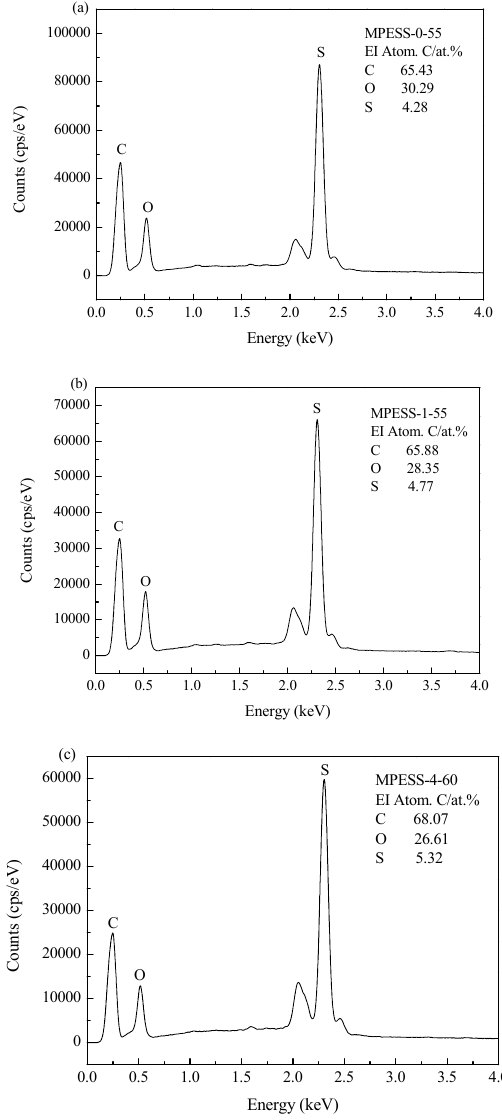
Figure 11. The EDX spectra of the prepared PES hollow fiber membranes.